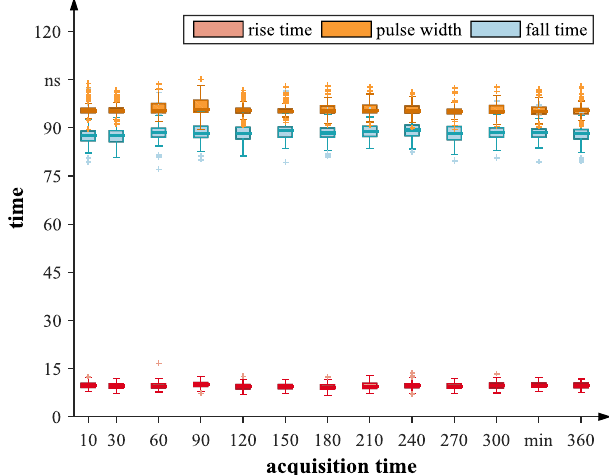
Fig. 6. Temporal development of the the pulse shape parameters rise time, pulse width and fall time as part of a long-term study carried out at a temperature level of 20 °C and an absolute humidity level of 11